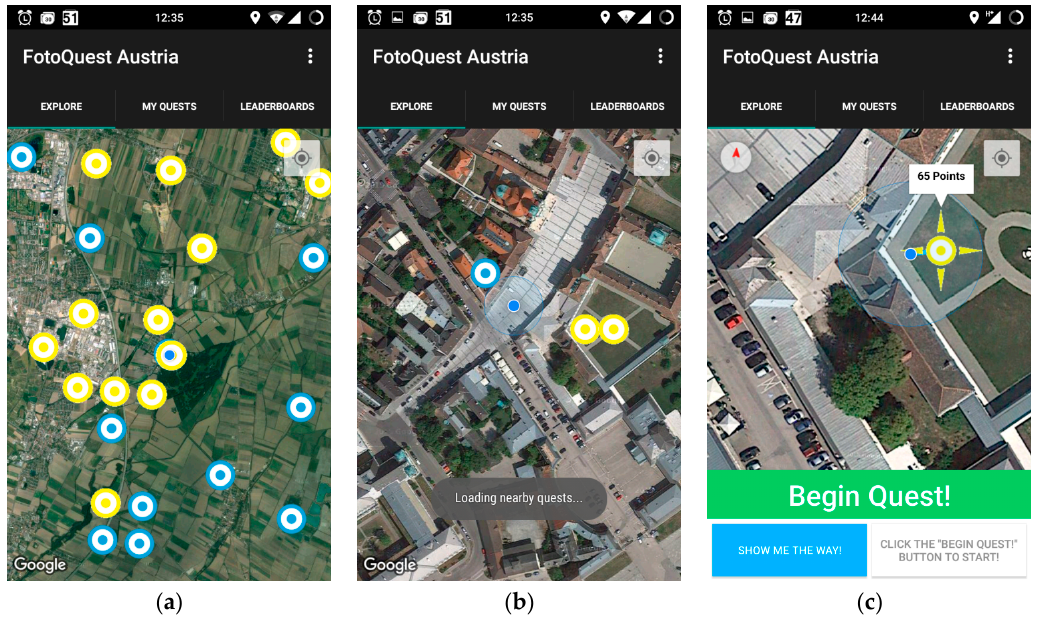
Figure 1. Screenshots from the FotoQuest Austria app showing: ( a ) the location of available quests in the surrounding area; ( b ) the available quests in the more immediate area; and ( c ) a nearby quest with the value in points that a player can achieve if the quest is successfully undertaken. Blue dots denote locations that have not yet been visited while yellow means that the quest has been undertaken between one and five times already.